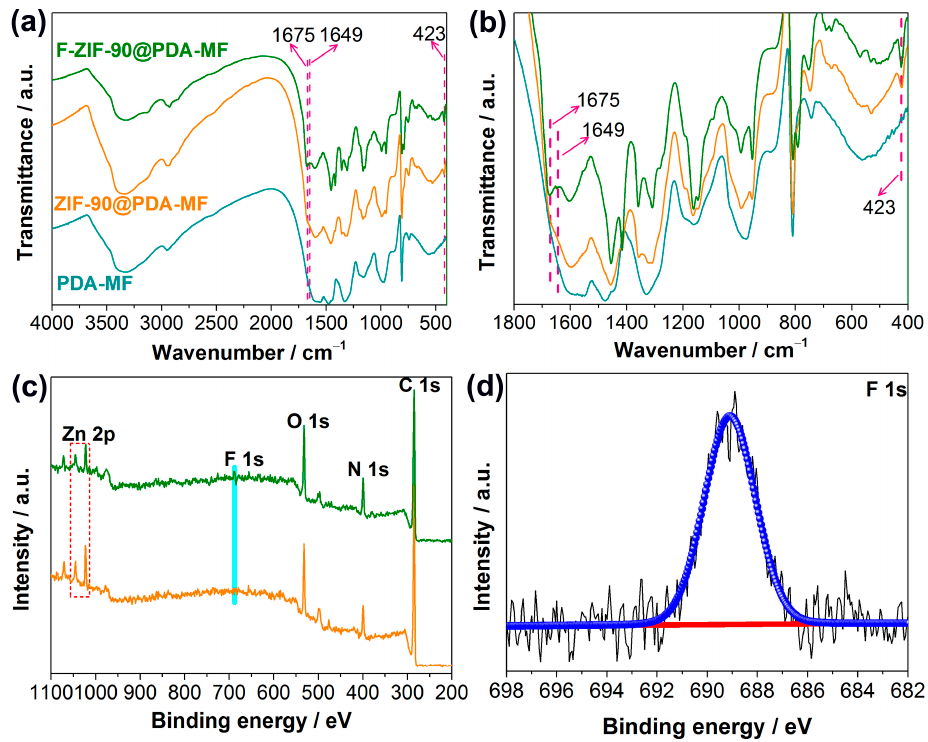
Figure 2. ( a , b ) Fourier-transform infrared spectra for PDA-MF, ZIF-90@PDA-MF and F-ZIF-90@PDA-MF composites. ( c ) Wide X-ray photoelectron spectroscopy (XPS) of ZIF-90@PDA-MF and